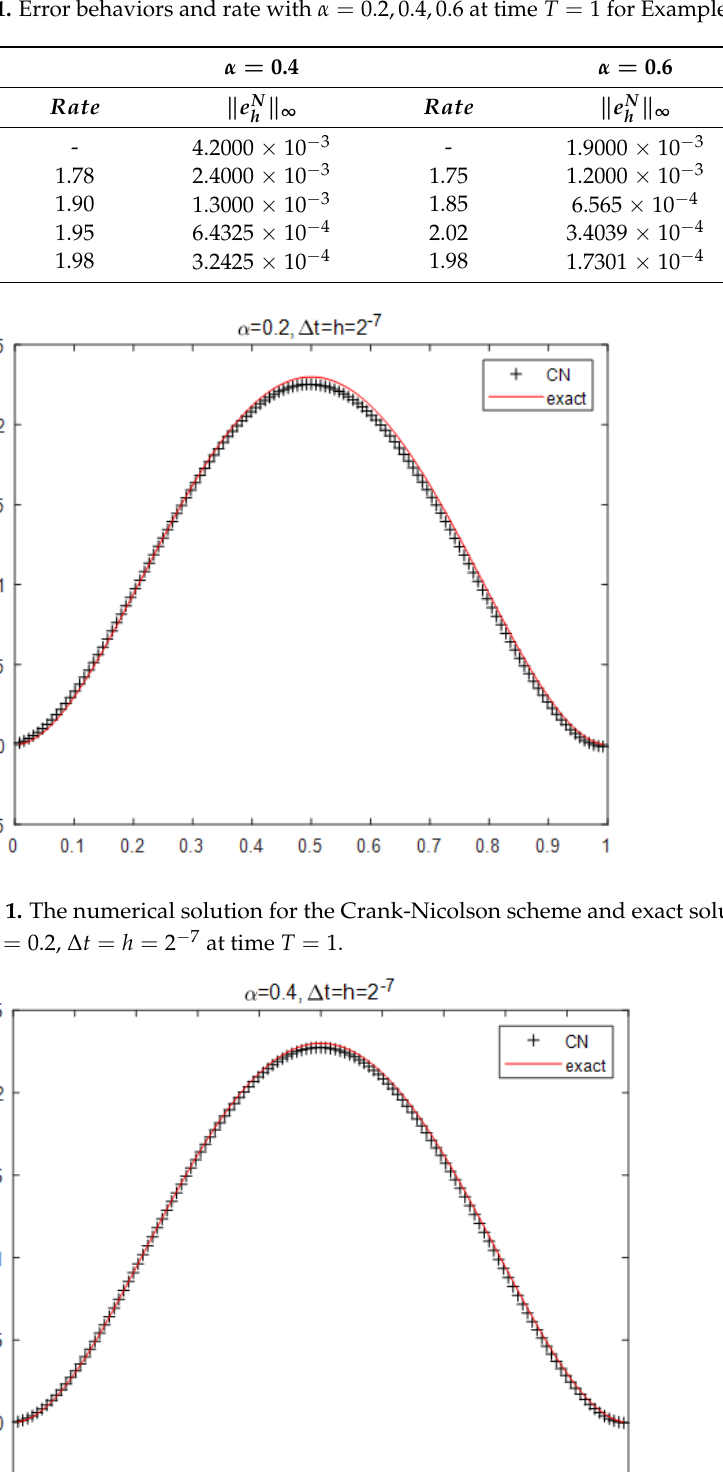
Table 1. Error behaviors and rate with α = 0.2,0.4,0.6 at time T = 1 for Example 1.